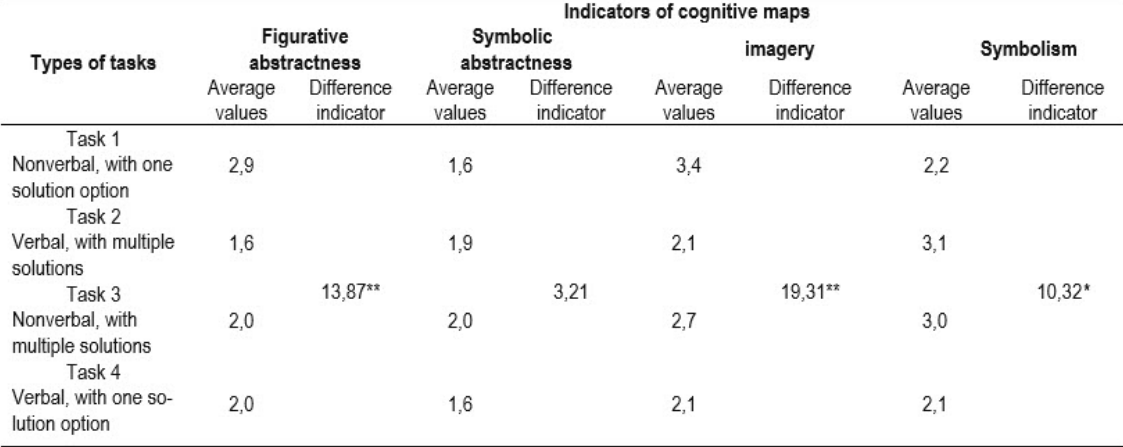
Differences in each individual indicator of cognitive maps performed without time constraints, based on the results of solving all types of